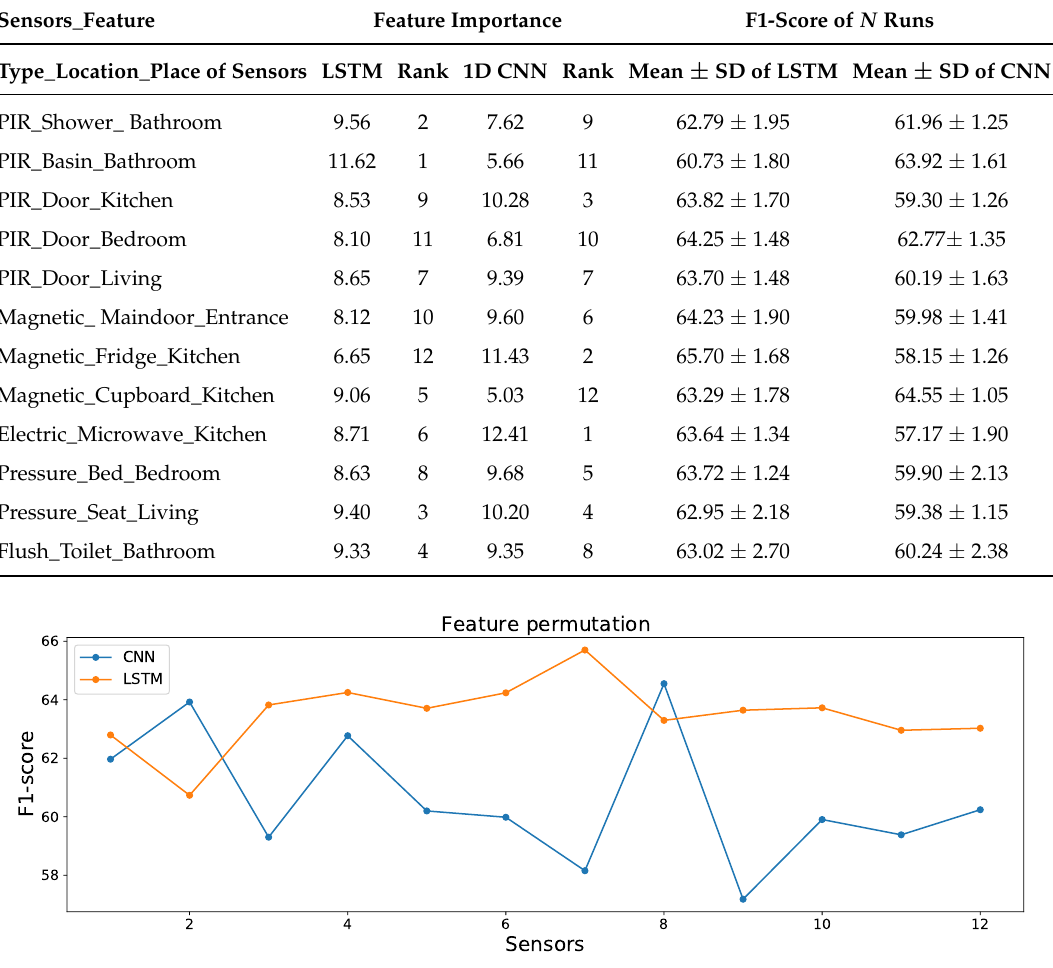
Table 8. Permutation feature importance of Ordonez Home B.